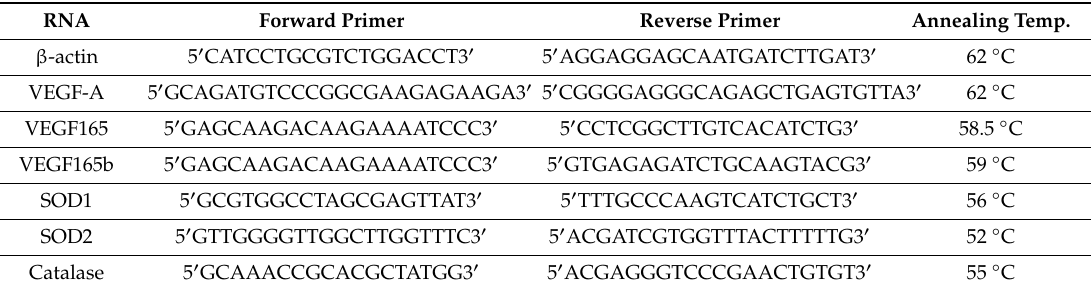
Table 1. Primer sequences and their annealing temperature for